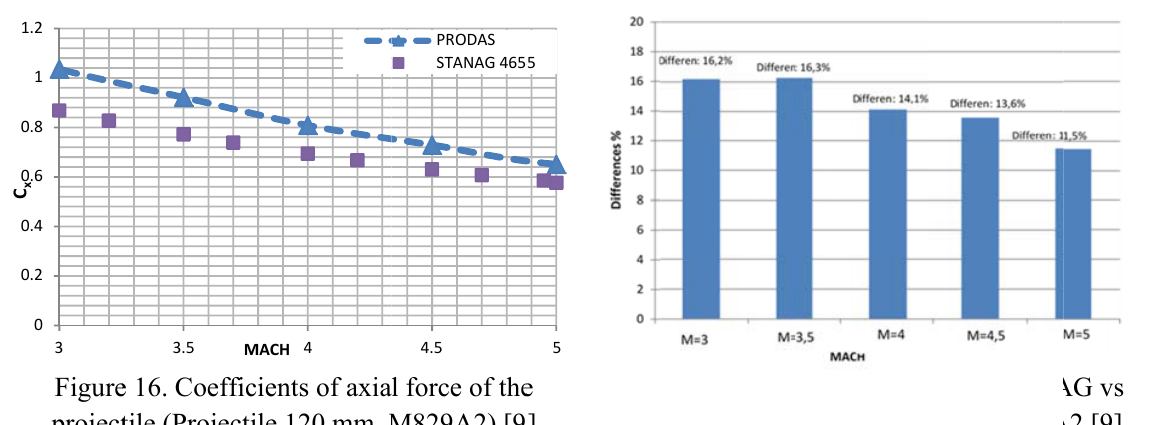
Fig PR ow around pr rojectile (12 own in figur Mach numbe by the nu m nts obtained model is give en in figure 1 ulations, the a analysis of th resistance for rce of a fluid orce and a ta angential for d resistance ocities M ≥ 1